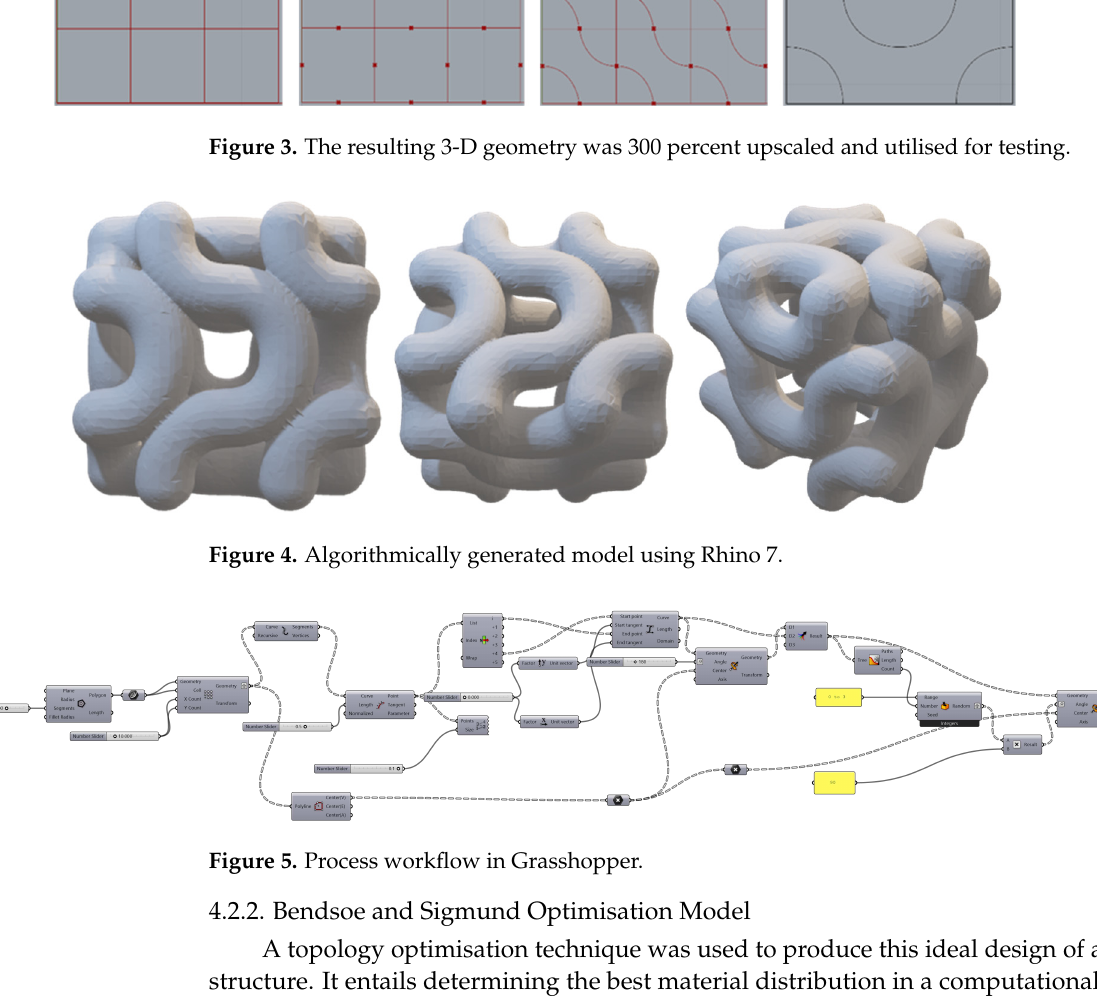
Figure 5. Process workflow in Grasshopper.